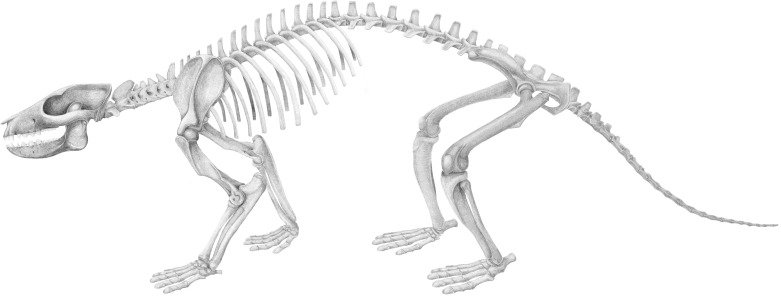
Skeletal reconstruction of Periptychus carinidens.